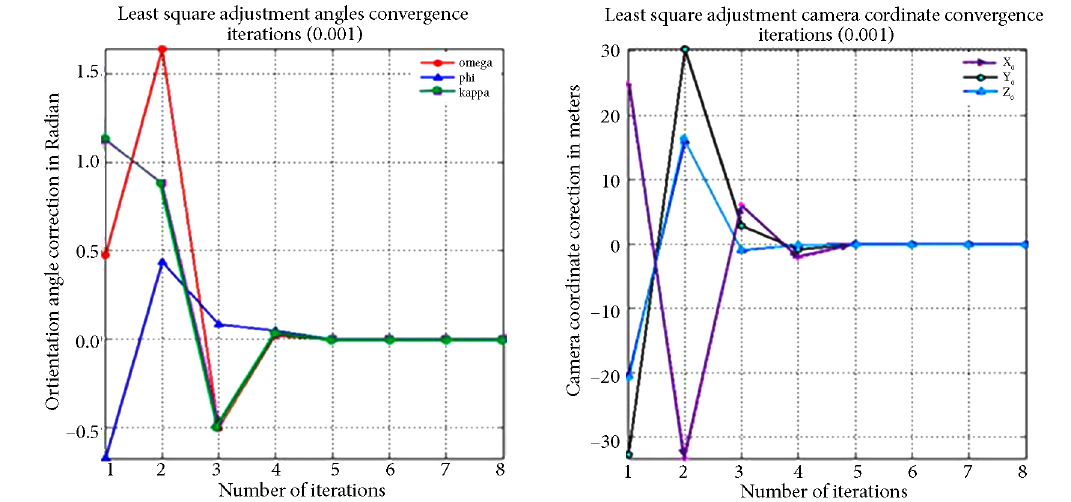
Figure 4. Iteration process for determination of exterior orientation parameters